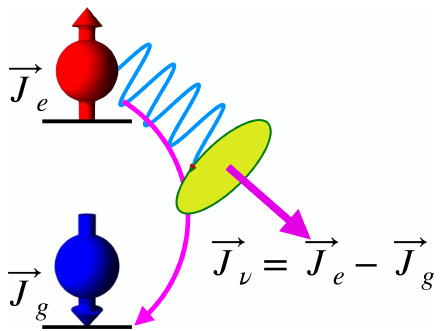
Figure 7. Angular momentum conservation during photon emis-